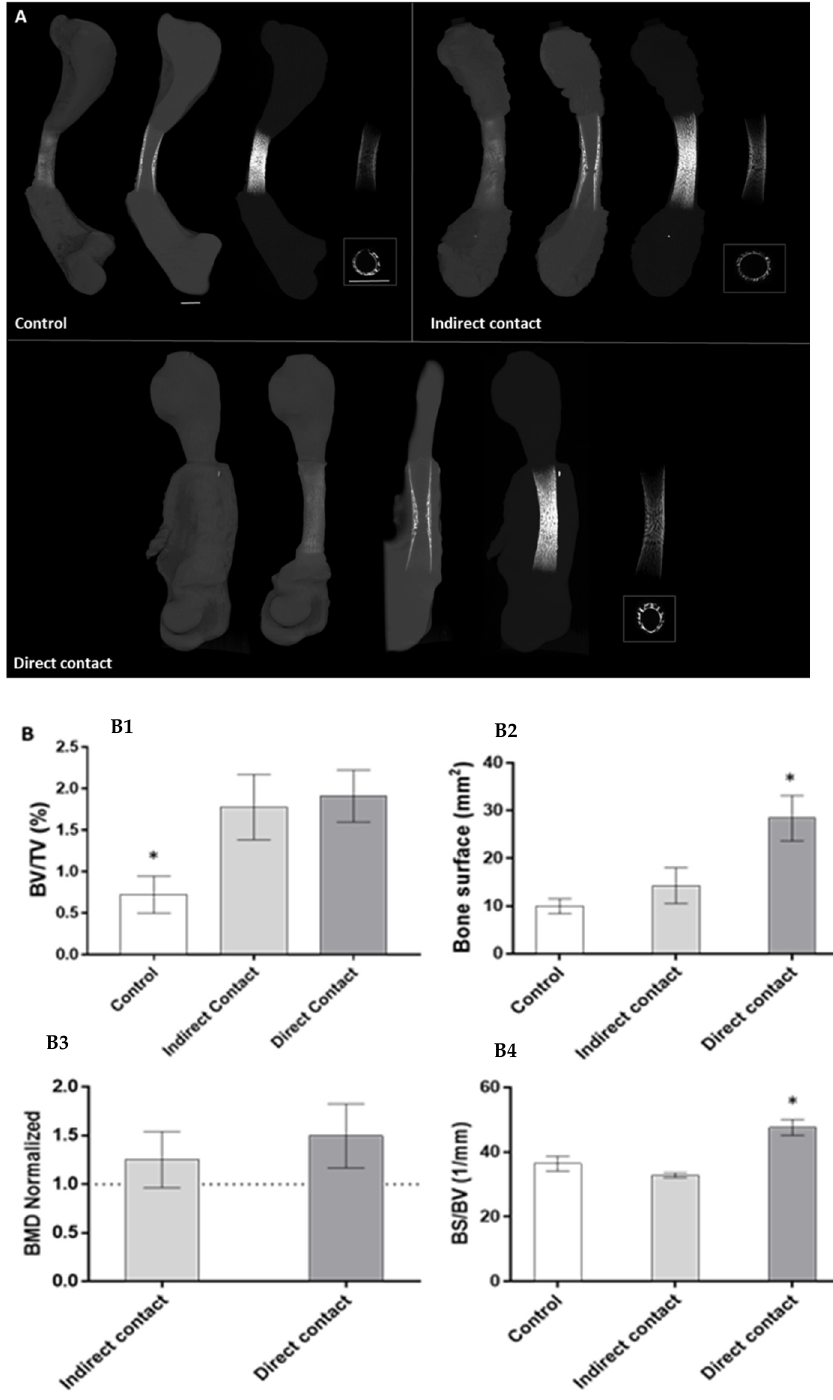
Figure 3. Microcomputed tomography analysis of D11 chick femora following 11-day culture in the absence (control) or presence of L-PRF membranes, in indirect and direct contact. ( A )—Three-dimensional representative images of samples (whole femur, sagittal section and maximum intensity projection of the whole femur, sagittal/ cross-section of the central diaphysis region, respectively) of the distinct experimental conditions. Scale bar corresponds to 500 µ m. ( B )—Quantitative morpho- metric parameters of the samples: ( B1 )—BV/TV; ( B2 )—BS; ( B3 )—BMD; ( B4 )—BS/BV). BMD was normalized to the control values, corresponding to 1 unit. * Statistically significant, p < 0.05, n =